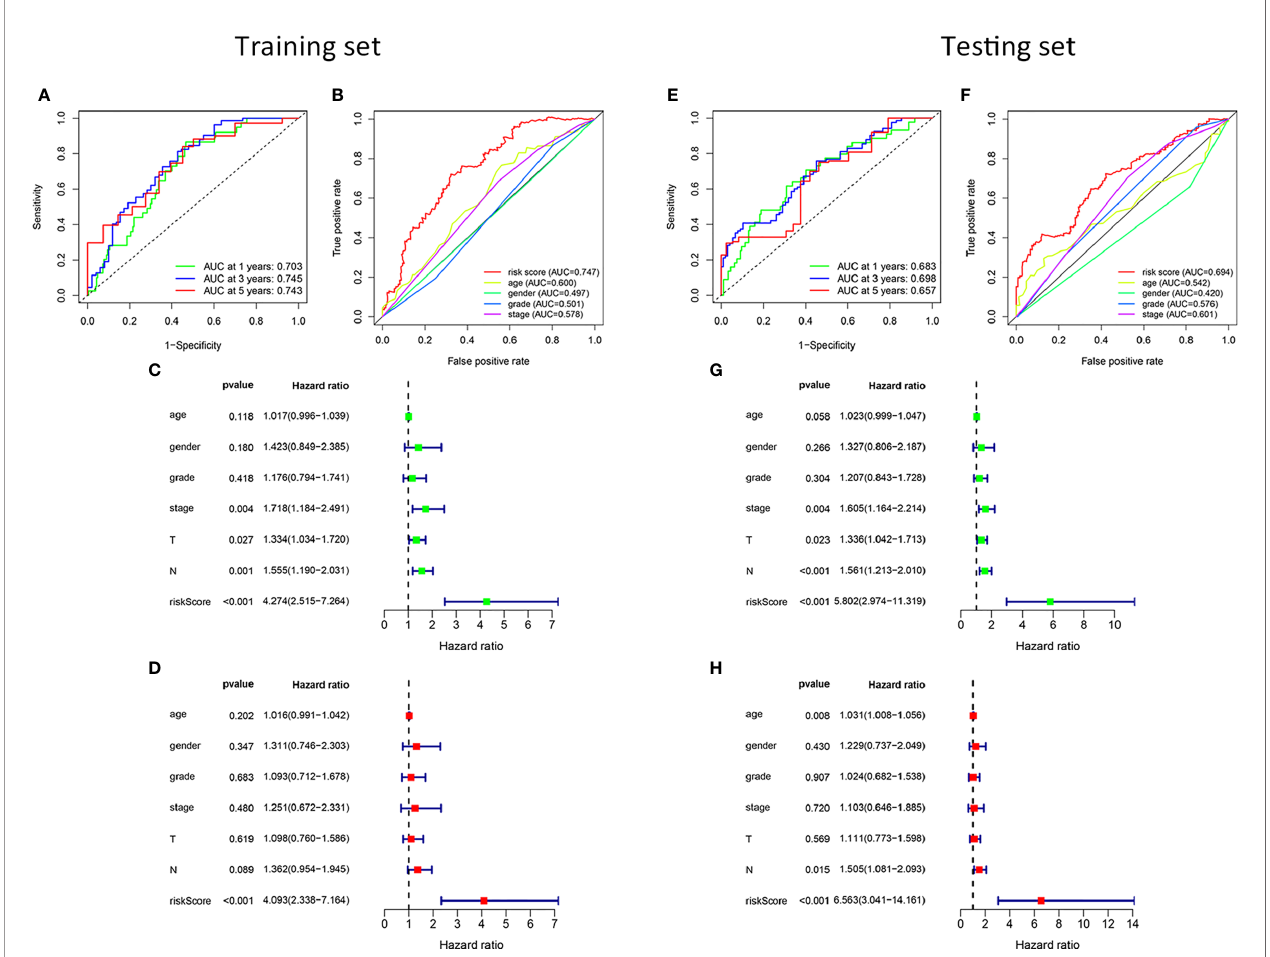
FIGURE 3 | Validation of the risk model. In the training set, the 1-, 3-, and 5-year ROC curves (A) . The ROC curves of clinicopathological characteristics and risk score for 3-year OS (B) . In the testing set, the ROC curves for 1-, 3-, and 5-year OS (E) . The ROC curves of clinicopathological characteristics and risk score for 3- year OS (F) . Univariate and multivariate Cox regression survival analysis was used to validate whether age, gender, grade, stage, T, N, and risk score could independently predict the clinical outcome of patients with HNSCC in the training (C, D) and testing sets (G, H)